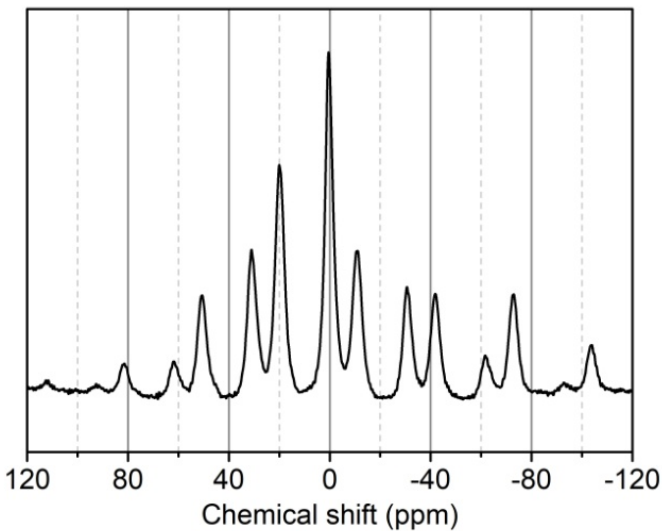
Figure 6. 13 P-NMRspectrum of phosphorylated KF sample prepared using 6 g PA and 6 g urea at 150 °C for 90 min.